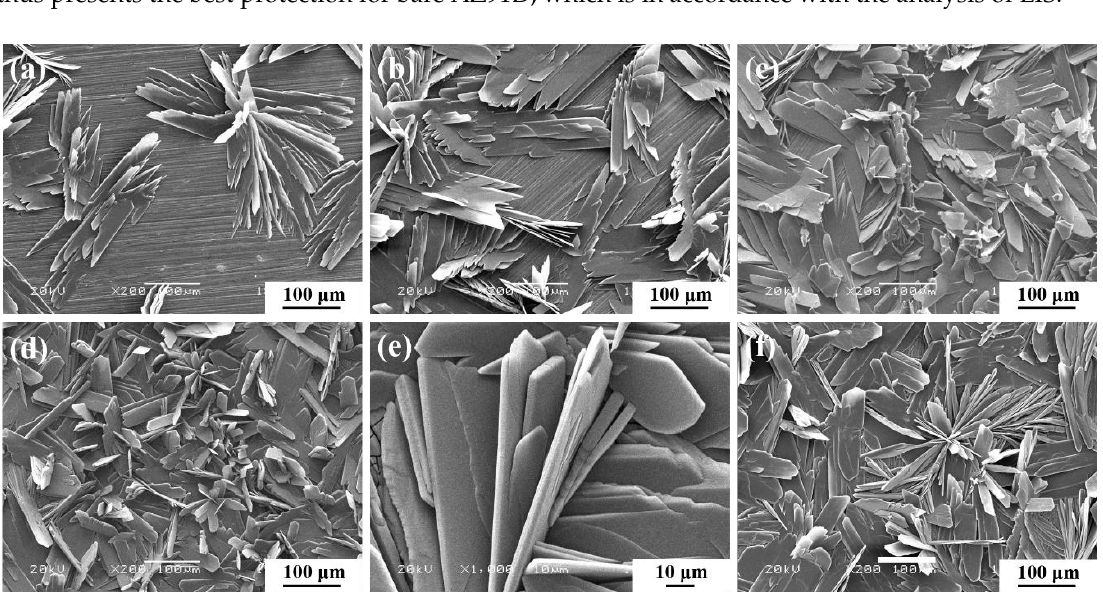
Figure 4. SEM micrographs of the calcium phosphate coatings under different conversion times: ( a ) 5 min; ( b ) 10 min; ( c ) 15 min; ( d ) 20 min; ( e ) magnification of 20 min and ( f ) 25 min.